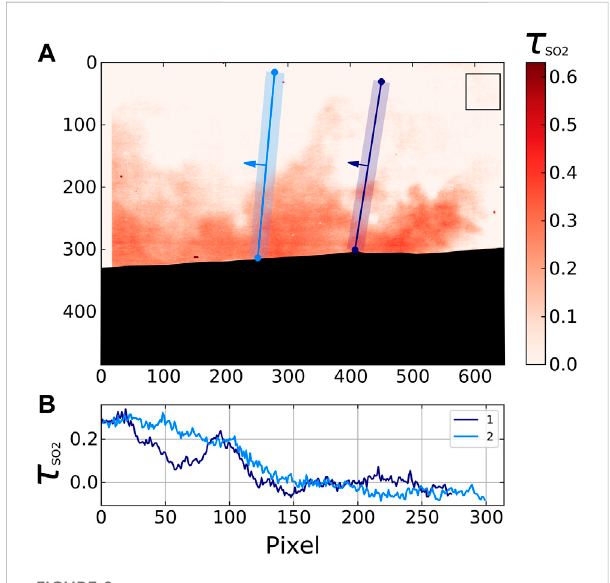
FIGURE 9 (A) Optical depth image ofK ī lauea volcano from an acquisitionat 20:21:35 UTC (10:21:35 HST) on 25th May 2022. The black rectangle indicates the region of clear sky where the intensity I 0 was estimated. (B) Opticaldepthvaluesacrossintegrationlinesshownin (A) .The dark blue line was used for emission rate retrievals whilst the light blue was the secondary line used for cross-correlation plume speed estimation.